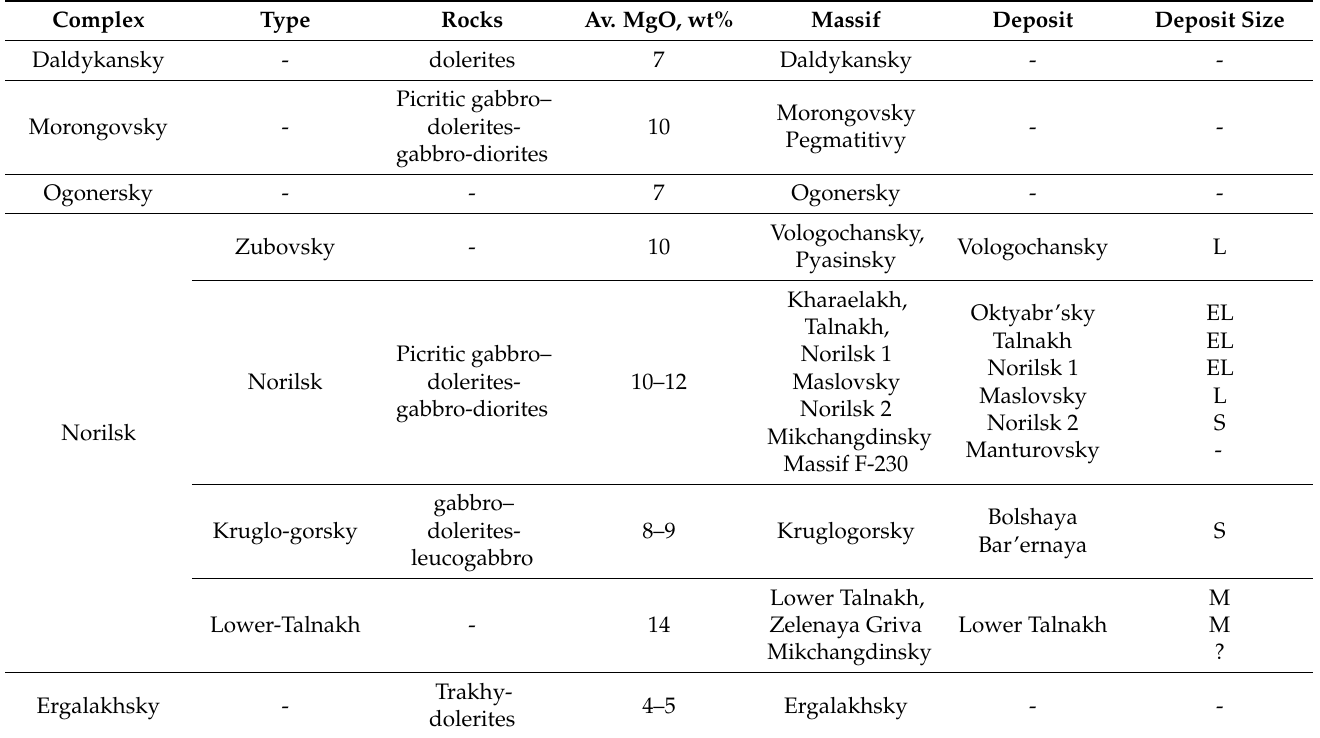
Table 1. Intrusive complexes of the Norilsk area (after